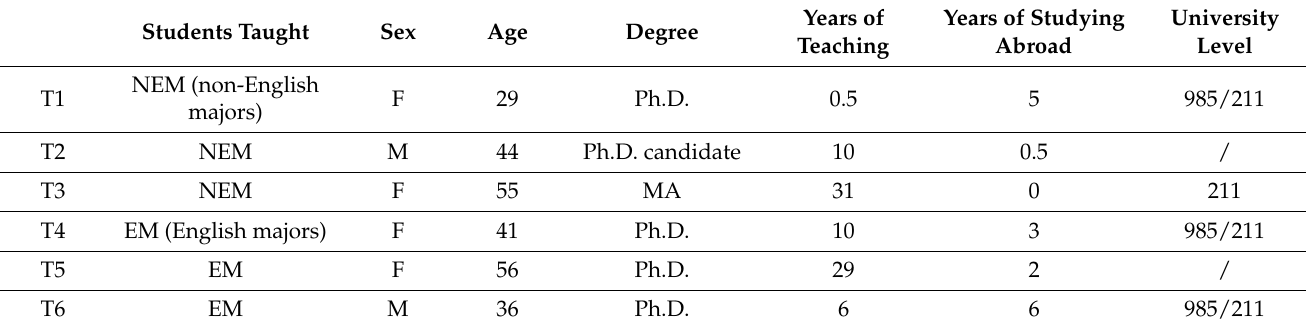
Table 1. Backgrounds of the Participating